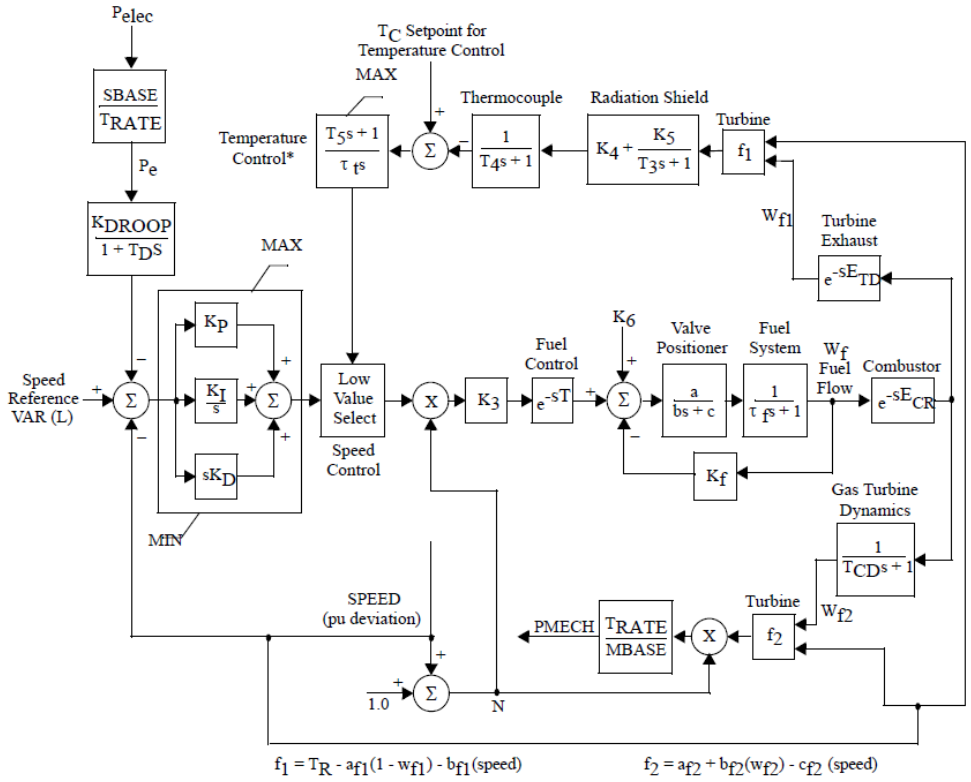
Figure 4. Classical gas turbine governor and prime mover. (The parameters are defined in the literature [27])